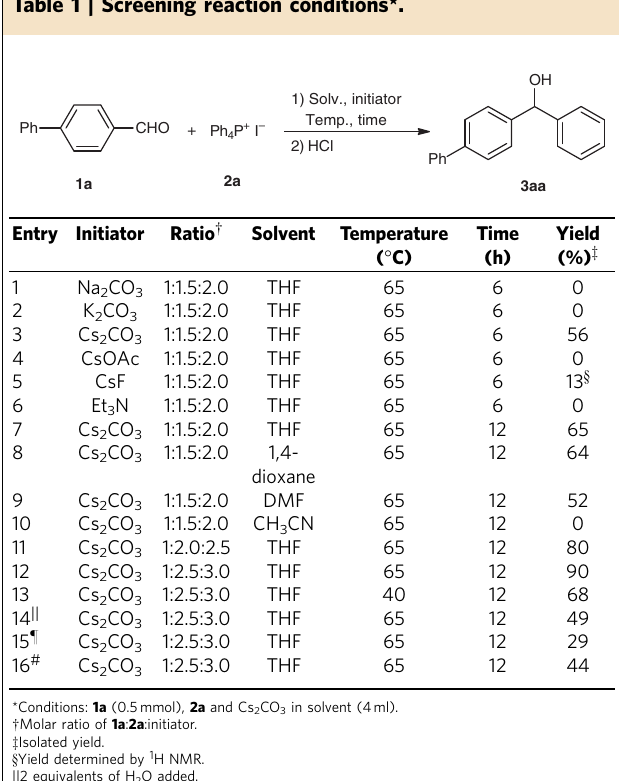
Table 1 | Screening reaction